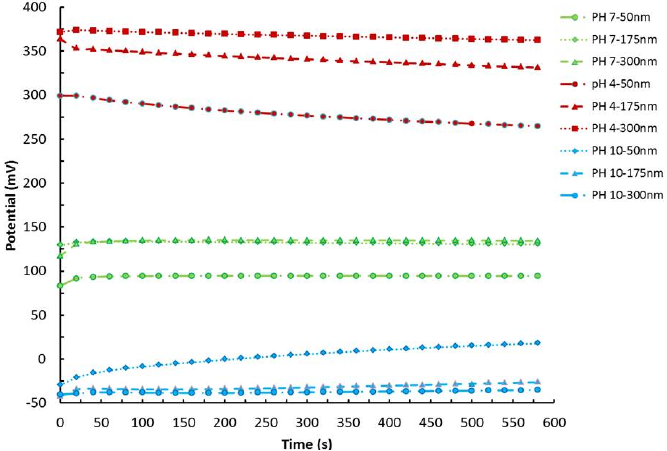
Figure 5. Measured potential in pH 4-7-10 to demonstrate stability. Reprint with permission from [21]. Copyright 2014